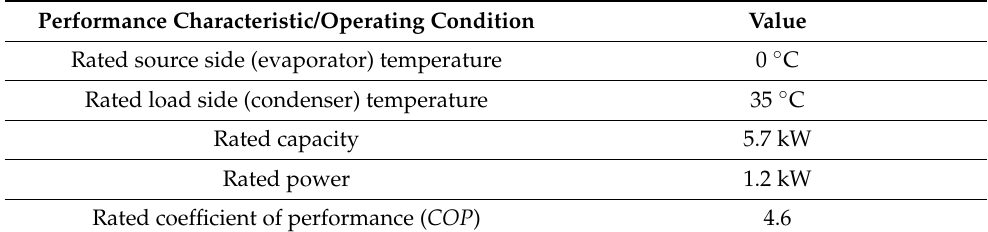
Table 10. Rated operating conditions and performance characteristics of the heat pump. Values are adopted from